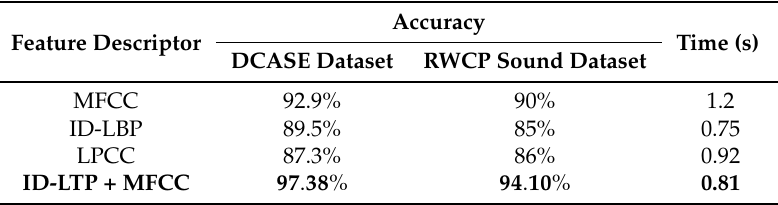
Table 3. Performance results for DCASE and RWCP datasets.